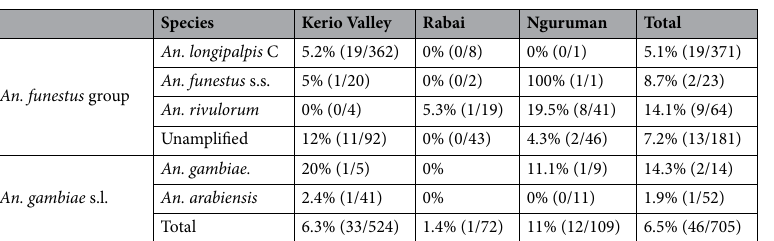
Table 1. Plasmodium falciparum sporozoite rates (%) by species in selected dryland areas, Kenya. Number in parenthesis indicates proportion of the total that tested positive for each species.